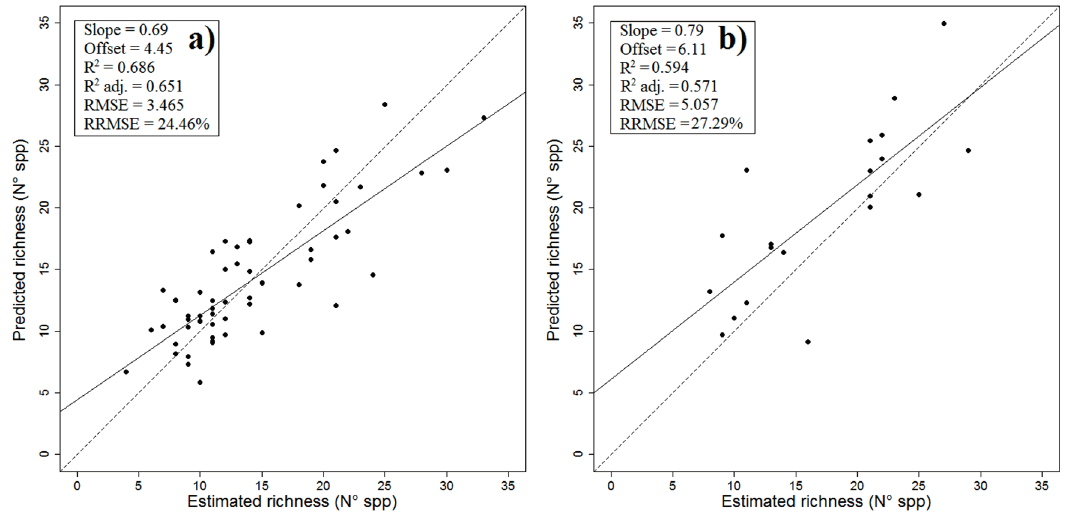
Figure 3. ( a ) Statistics of the estimated richness vs. predicted richness obtained in the model construction (60 clusters); ( b ) Statistics of the estimated richness vs . predicted richness obtained in the independent validation set (20 clusters). Table 1. Evaluation of the assumptions of the multiple linear regression and validation regression analysis. *: Assumptions acceptable ( p -value > 0.05); € : Assumptions